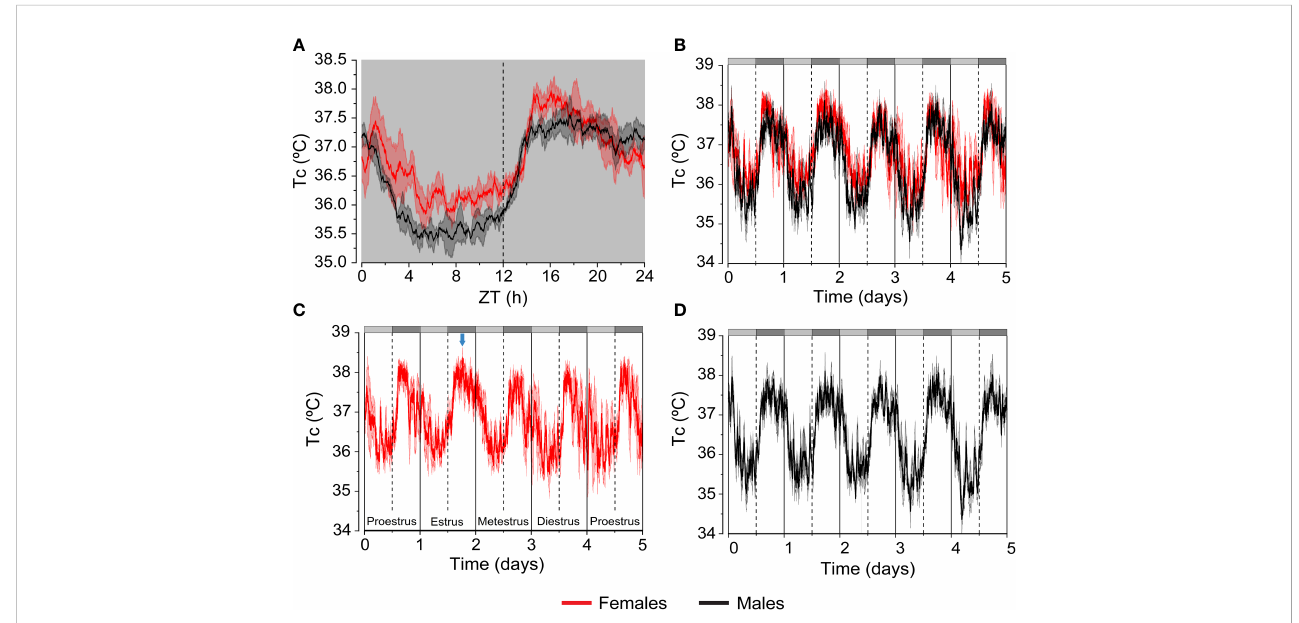
FIGURE 2 Differences in Tc between female and male mice. Continuous telemetric recordings of Tc in C57B6/J female and male mice housed at 21 °C. Mice were exposed to constant darkness (D/D) for 5 days to analyze circadian fl uctuations. (A) The graph represents daily average of the Tc values recorded during the last 3 days. (B – D) The graphs represent daily variation of the Tc values recorded during 5 days in females and males. Subjective day and subjective night are indicated by the light grey and dark grey bars, respectively. The blue arrow points at the characteristic shape of Tc during estrus. n= 4-5 mice/ group of 5-8 months of age. Results are represented as mean ± SEM. These graphs were elaborated from data of experiments reported in Reimu ́ ndez et al., 2022